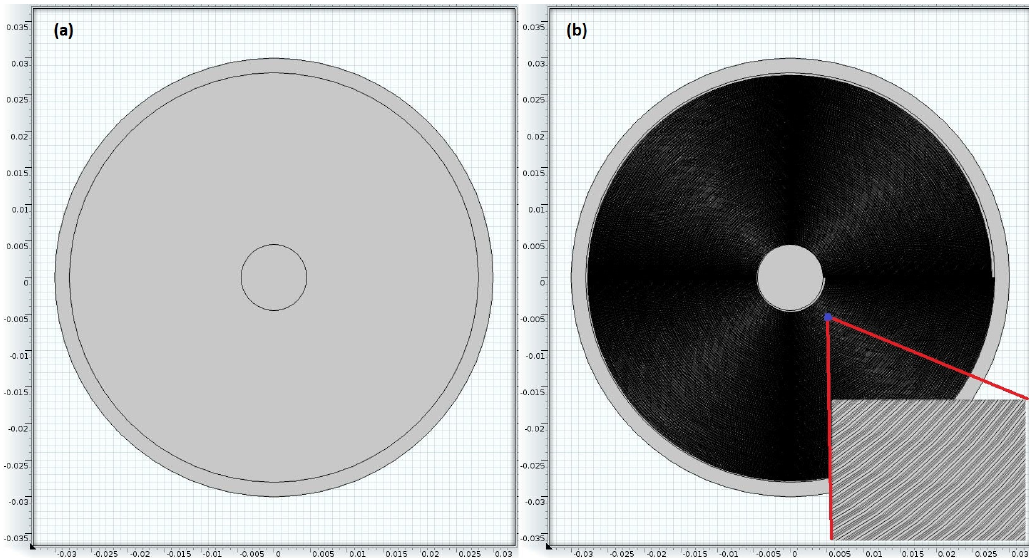
Figure 3. Internal representations of the cell: ( a ) homogeneous and ( b )